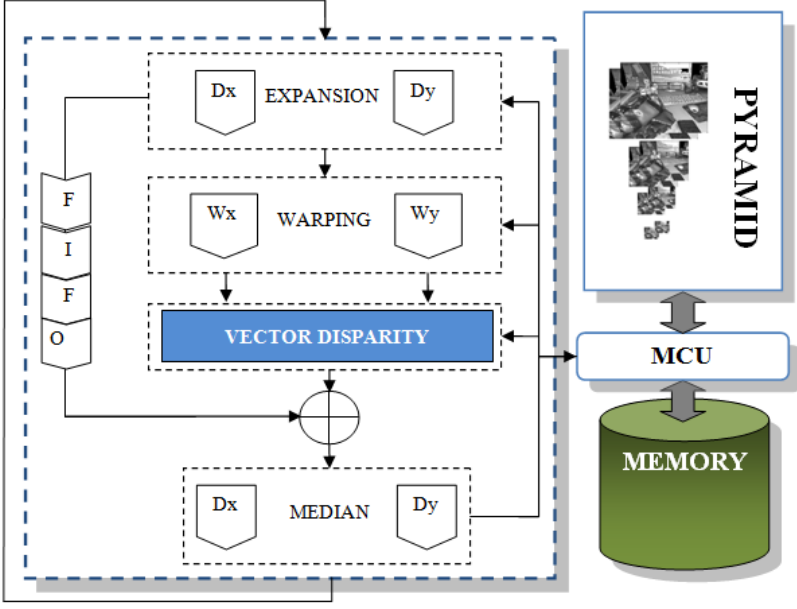
Figure 6. Hardware system architecture. Right side: the pyramid and its communication with memory. Left side: multi-scale computation (scaling, warping, merging, median filtering and vector disparity